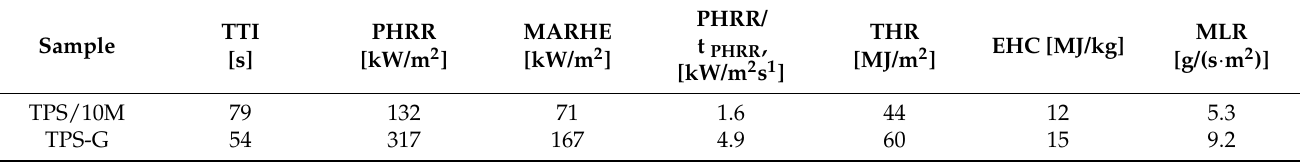
Table 3. The cone calorimeter results of TPS/10M and TPS-G.